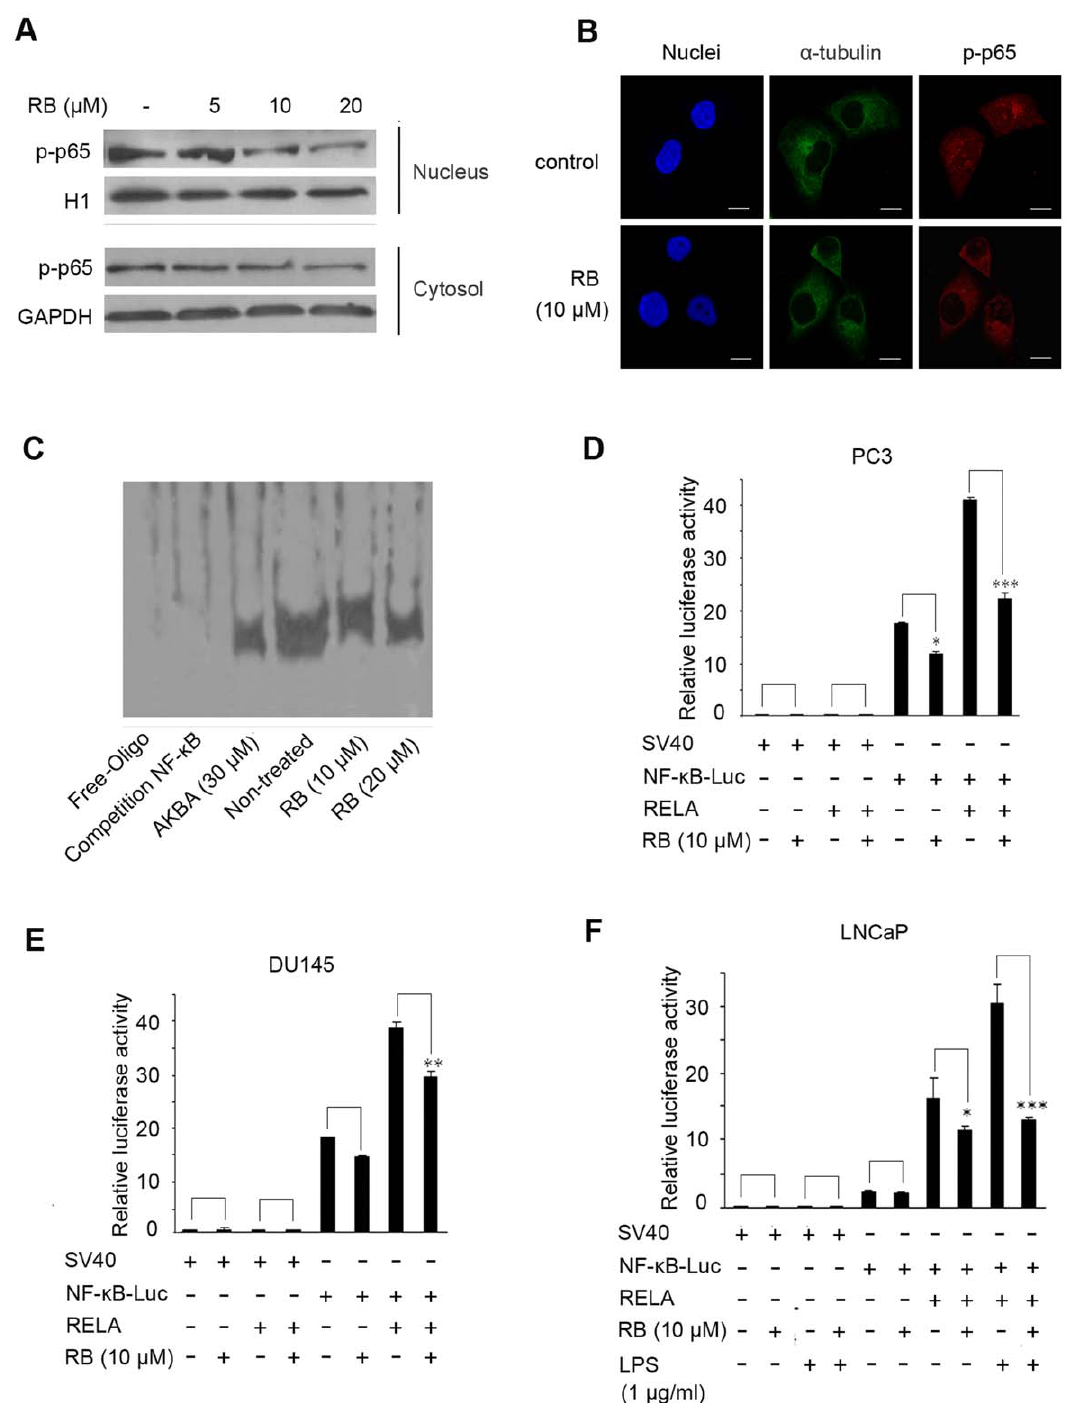
Figure 2. The effects of RB on function of NF- k B invitro . (A) RB dosage-dependently inhibited the nuclear localization of p65 Lysates from cytoplasm and nucleus respectively after treating of PC3 cells with RB for 24 h were used for western blot. GAPDH and H1 respectively served as the loading control. (B) Immunofluorescence analysis of the inhibitory nuclear localization of p65 by RB-treatment for 12 h in PC3 cells. For confocal microscopy, a -tubulin and p-p65 were immunostained, with nuclei stained with DAPI. (Scale bar, 10 m m). (C) Pretreatment of PC3 cells with RB inhibited binding of nuclear extracts to the NF- k B binding site, as detected by electrophoretic mobility shift assay. Lysates from nuclei after treating of PC3 cells with RB for 24 h were used for EMSA. (D), (E) and (F) RB decreased NF- k B activation in PC3 and DU145 cells, and inhibited LPS-induced NF- k B activation in LNCaP cells. The inhibition was more significant when pNF- k B-Luciferase and RELA expression vector co-transfected. Transiently transfected cells were preincubated with RB for 24 h. The luciferase assay was done as described in Materials and Methods . In (D)–(F), results are the mean 6 S.E. of three independent experiments, each performed in triplicate. p , 0.05 (*), p , 0.01 (**), p , 0.001 (***) versus RB-untreated control group respectively.